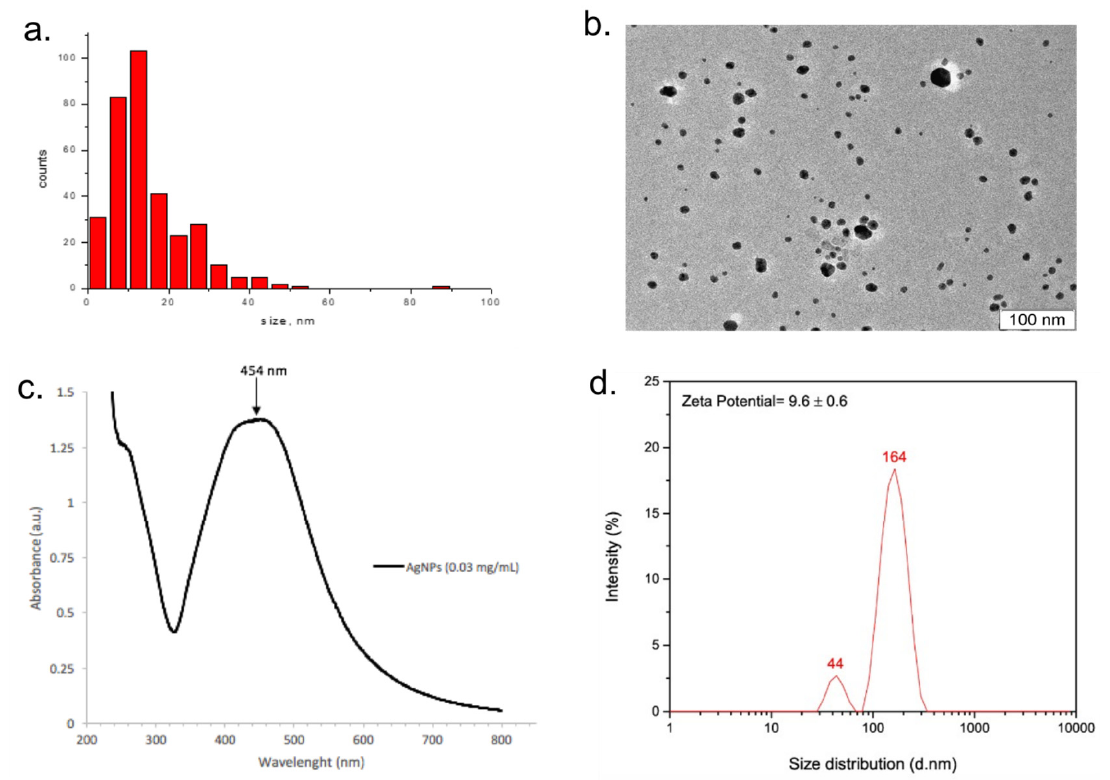
Figure 2. Physicochemical characteristics of Argovit-C TM AgNPs. TEM data: ( a ) AgNP size distribution, ( b ) TEM image, ( c ) UV–visible absorption spectrum (for 0.03 mg/mL of metallic silver), and ( d ) zeta potential and hydrodynamic diameter. The figure is taken from [14].